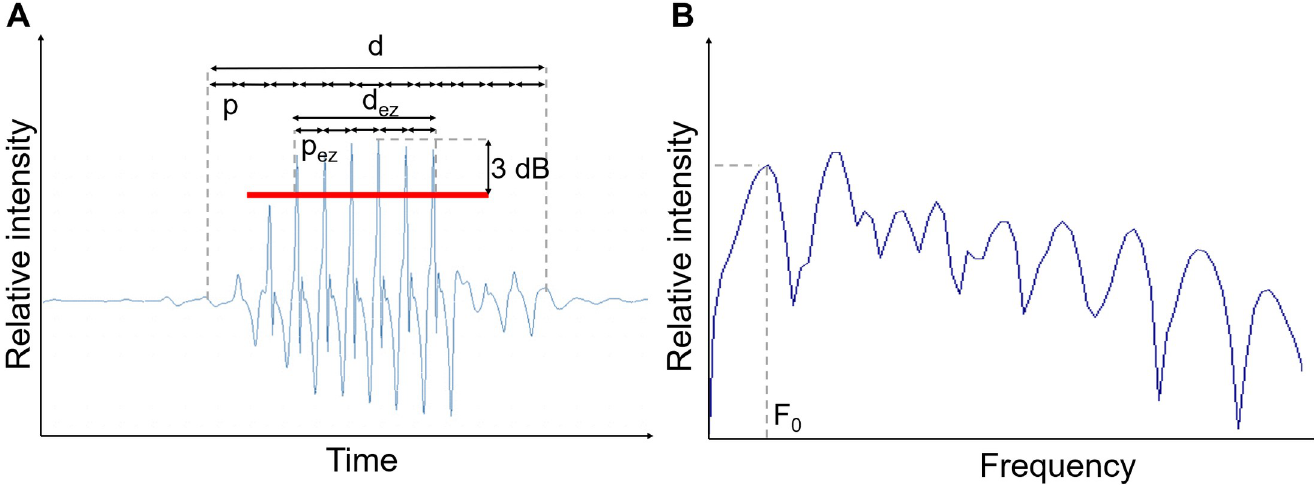
Fig 2. A. Oscillogram and B. power spectrum of a sound with the features measured. d = duration, d ez = duration of the energetic zone, p = period, p ez = period in the energetic zone, F 0 = fundamental